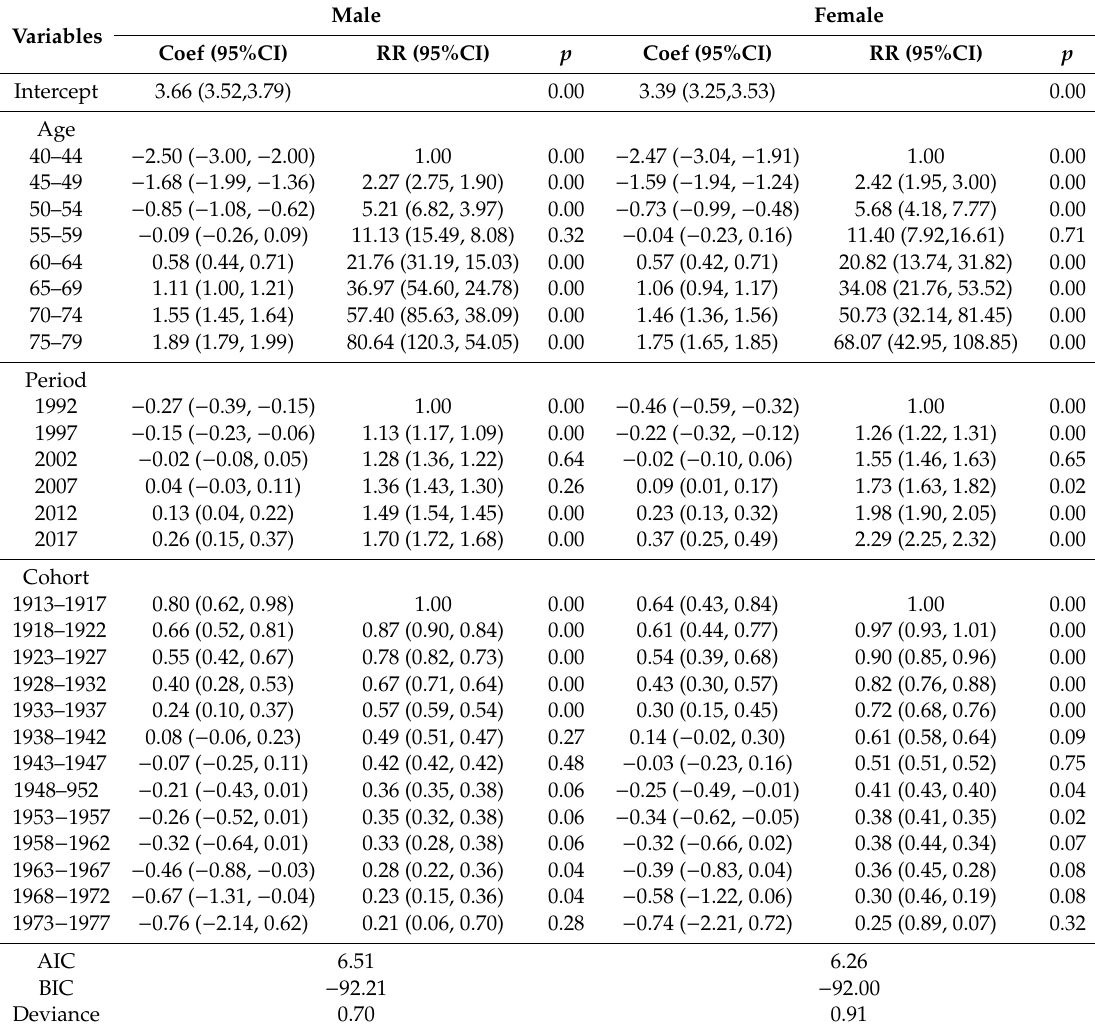
Table A2. APC model analysis results of COPD mortality in the U.S., 1992–2017.